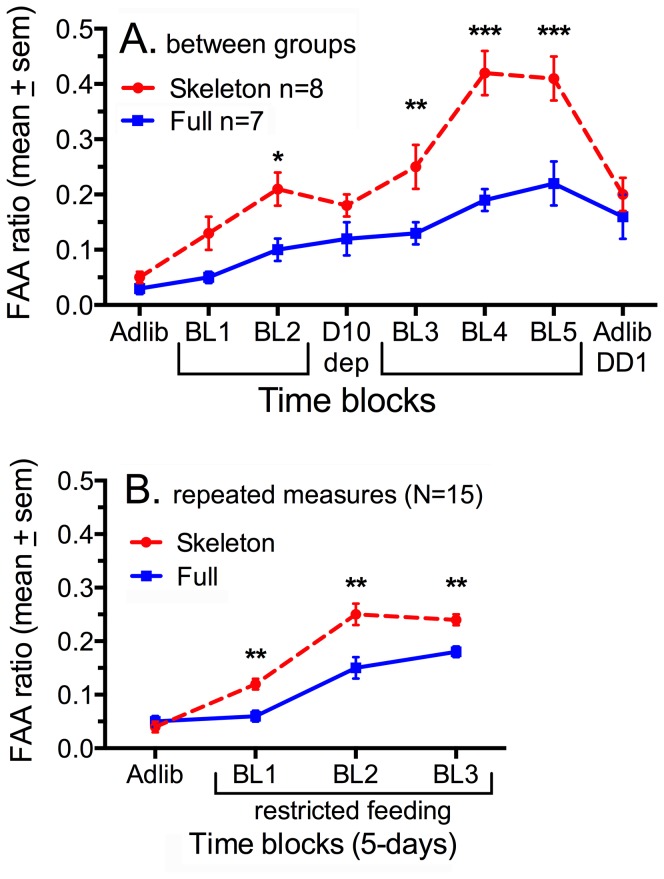
Group mean (± sem) food anticipatory activity (FAA) ratios of rats in a skeleton photoperiod (red dashed curve) and a full photoperiod (blue curve).Ratios were calculated by dividing the activity counts registered during the 2h prior to mealtime (ZT4-6) by total activity occurring from ZT12-24. A. FAA ratios for skeleton and full photoperiod groups averaged in 5-day blocks during ad-lib food access and 25 days of restricted food access (BL1-5). No food was provided on day 9 of restricted feeding, and thus day D10 is plotted separately. B. FAA ratios for the first 3 blocks of 5 days of restricted feeding, for all 15 rats tested under both the skeleton and the full photoperiods cycles (within subject, counterbalanced for order). Differences between groups: *p<.05, **p<.01, ***p<.001.